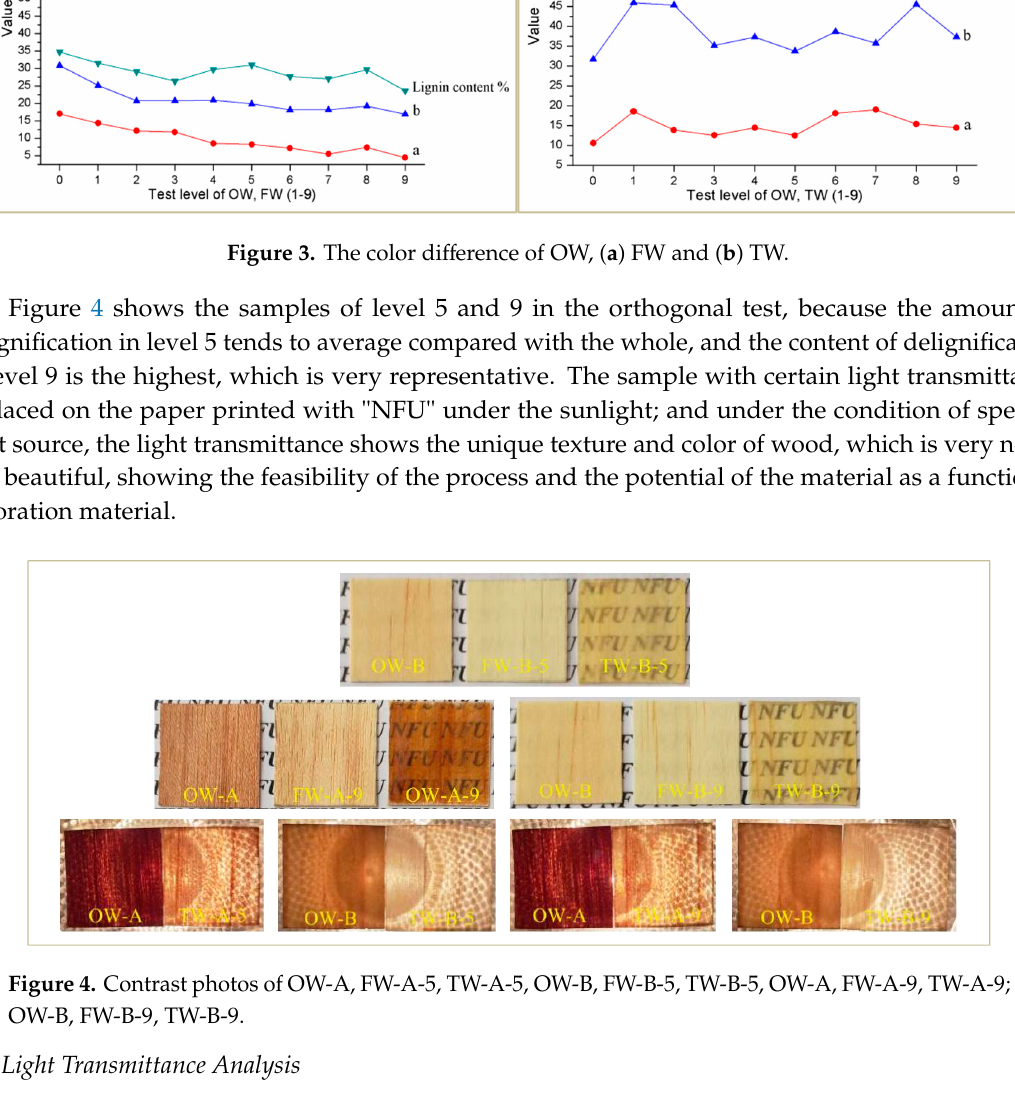
Figure 4. Contrast photos of OW-A, FW-A-5, TW-A-5, OW-B, FW-B-5, TW-B-5, OW-A, FW-A-9, TW- A-9; OW-B, FW-B-9,